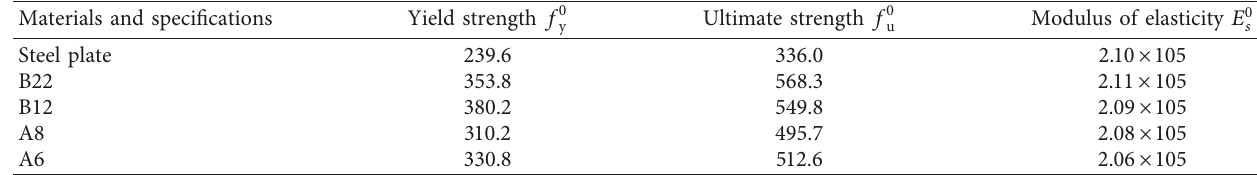
Table 2: Properties of rebars and steel plate (unit: N/mm 2 ).